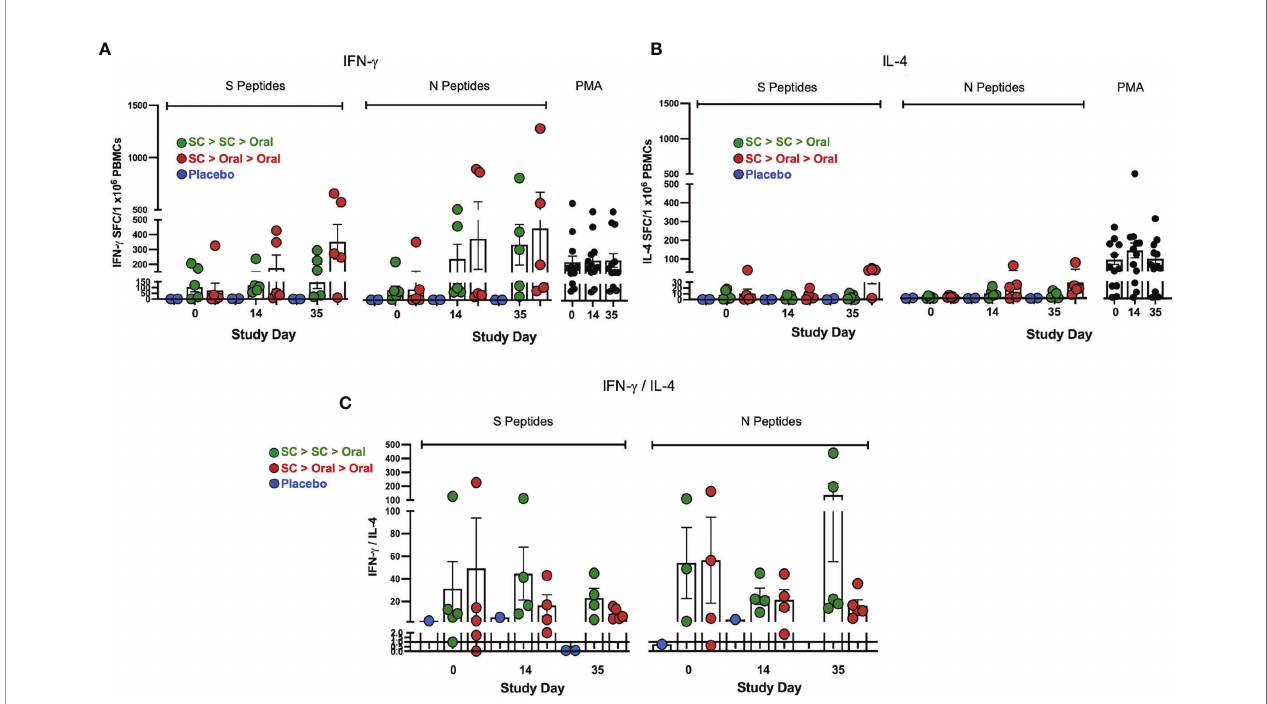
FIGURE 4 | Interferon- g (IFN- g ) and interleukin-4 (IL-4) secretion by T cells . (A) IFN- g ) and (B) IL-4 secretion by T cells in response to S and N peptides in ELISpot is shown. The PMA positive control is at right on each graph. (C) IFN- g /IL-4 ratios greater than 1 (line) suggest T helper cell 1 (Th1) bias of T-cell responses; ratios for samples that gave IL-4 values of zero are not shown. Statistical analysis performed using one-way ANOVA with Dunnett ’ s post-hoc comparison of vaccinated groups with placebo (no signi fi cant differences were observed due to individual variation). Data graphed as the mean and